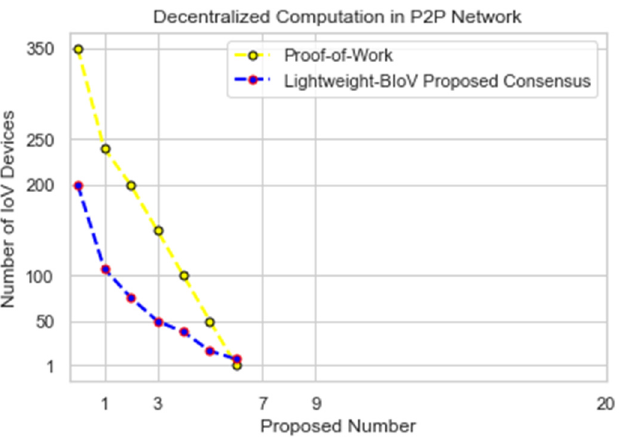
Figure 6. P2P Consortium Network Simulation Result of Decentralized Distributed Computation.